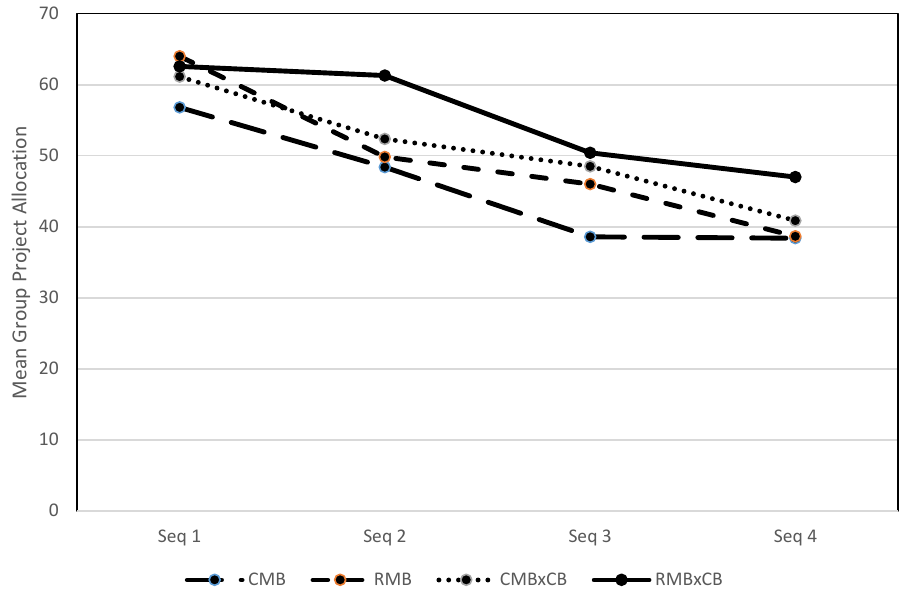
Figure 1. Mean Group Project Allocation by Sequence. Table 3. OLS Regression with Robust Clustered Standard Errors. Dependent Variable: Total Group Contribution to the Group Project.